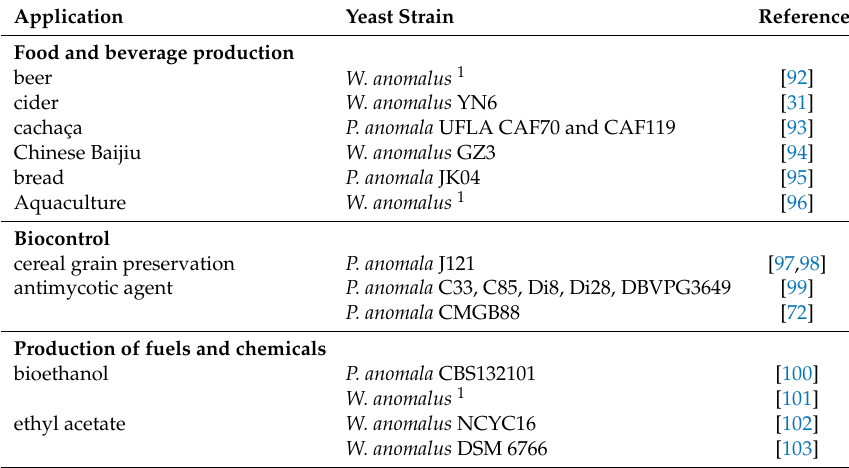
Table 2. Biotechnological applications of W. anomalus beyond wine